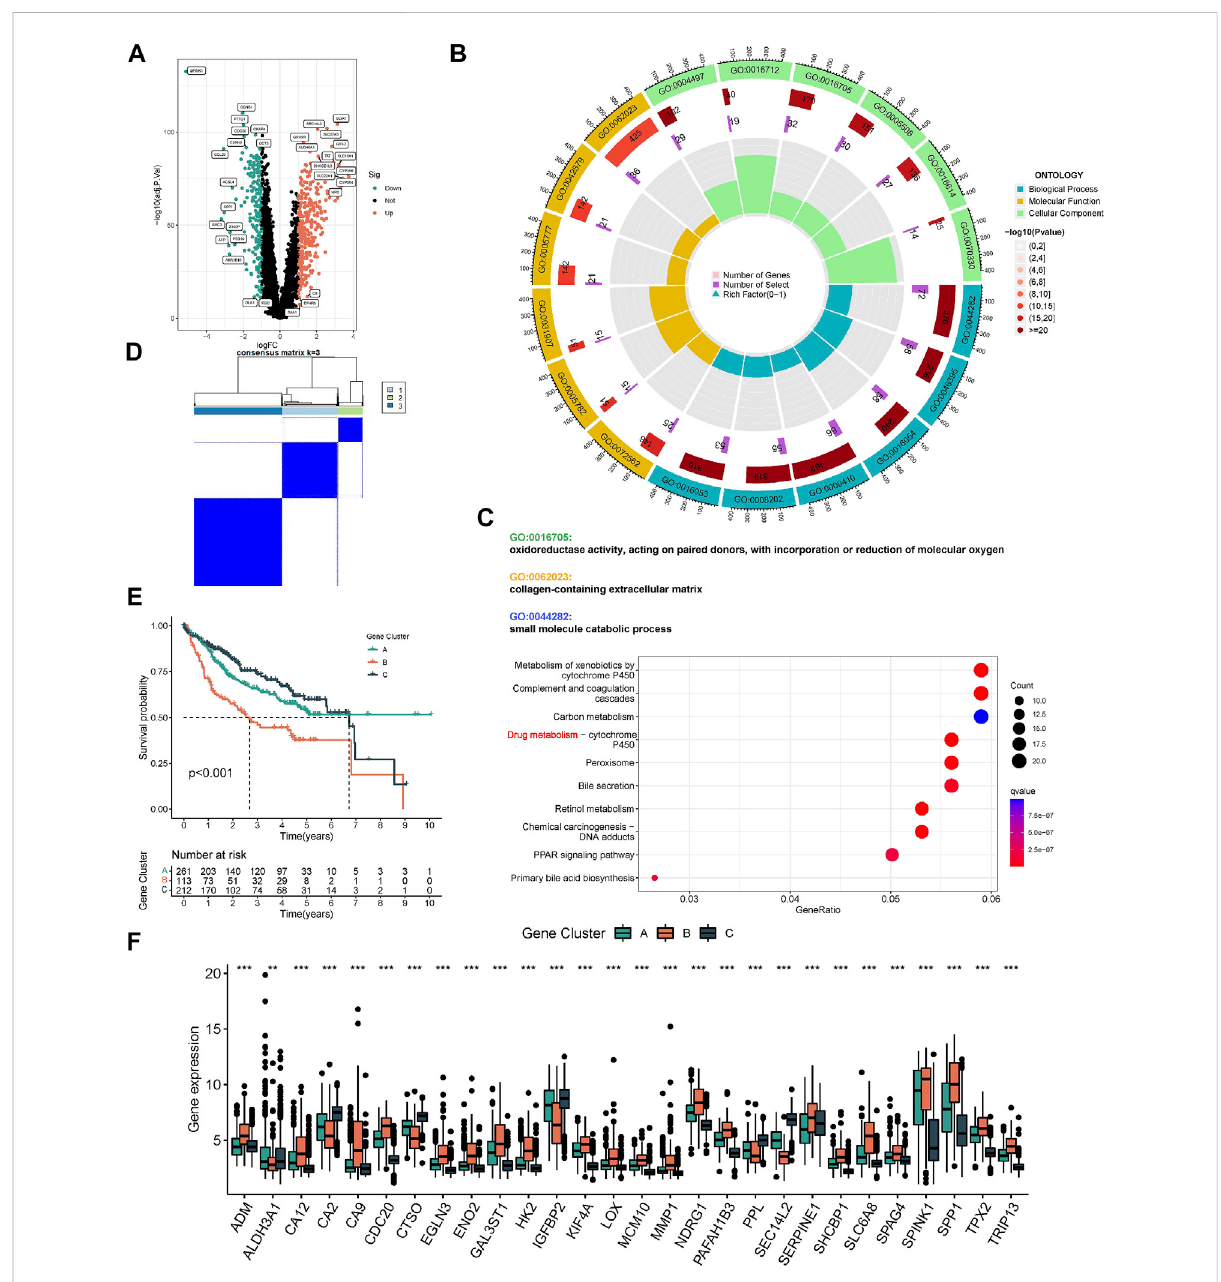
FIGURE 4 Molecular subtypes based on DEGs. (A) The Volcano plot showed DEGs in different subtypes. Heat map of unsupervised clustering analysis. (B) ThecircleplotofGOenrichmentanalysisbasedonDEGs. (C) ThebubbleplotofKEGGenrichmentanalysisbasedonDEGs. (D) Theclassi fi cationwas optimal when the k value = 3. (E) Kaplan-Meier analysis of overall survival time in different molecular subtypes based on DEGs. (F) The Box plot of mRNA expression of HRGTs in different molecular subtypes. * p < 0.05, ** p < 0.01, *** p <